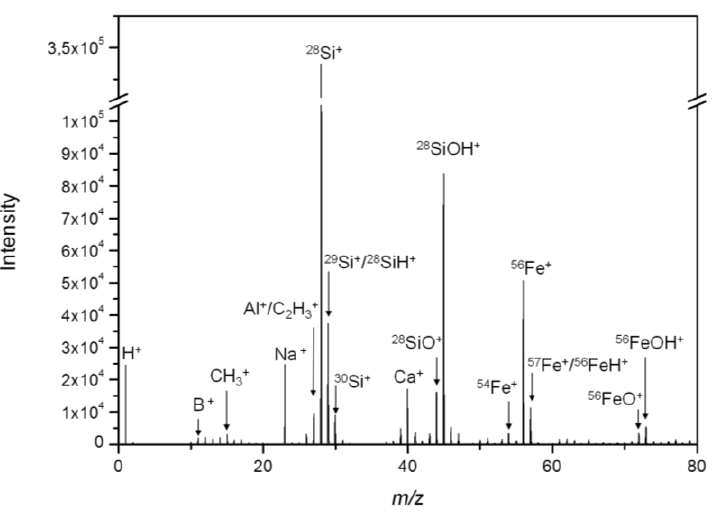
Figure 2. Mass spectrum of the Fe-Si-NP with a Fe/Si core/shell structure. Particles were deposited on an aluminum substrate and analyzed by ToF-SIMS. The particle components Si x O y H z+ and Fe x O y H z+ and their respective isotopes are detected along with hydrocarbons (CH 3+ and C 2 H 3+ ), substrate components (Al + ), and other residues possibly linked to the production process (B + , Na + , and Ca + ).